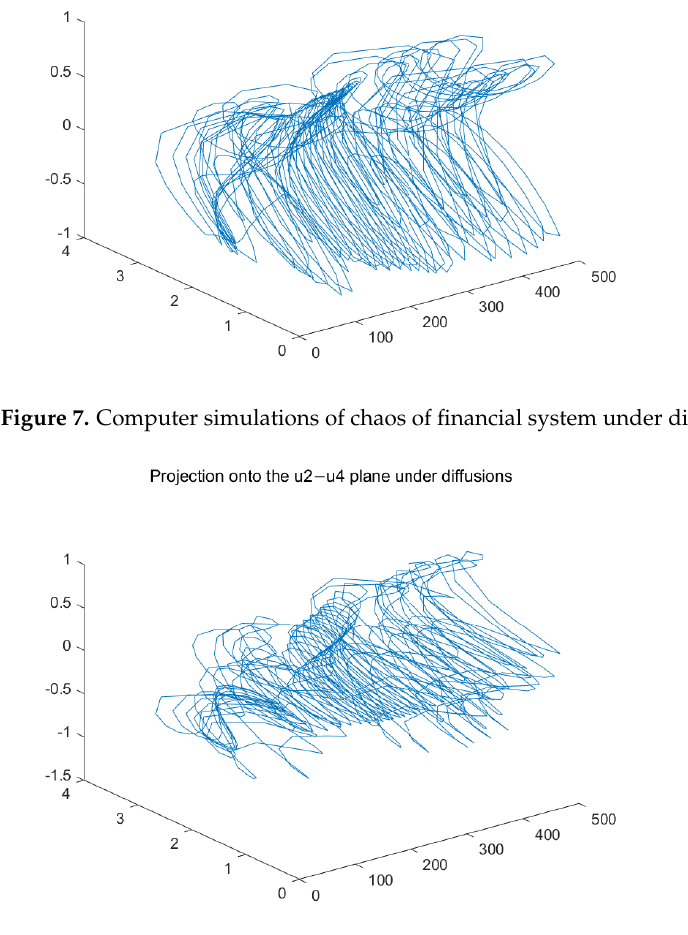
Figure 8. Computer simulations of chaos of financial system under